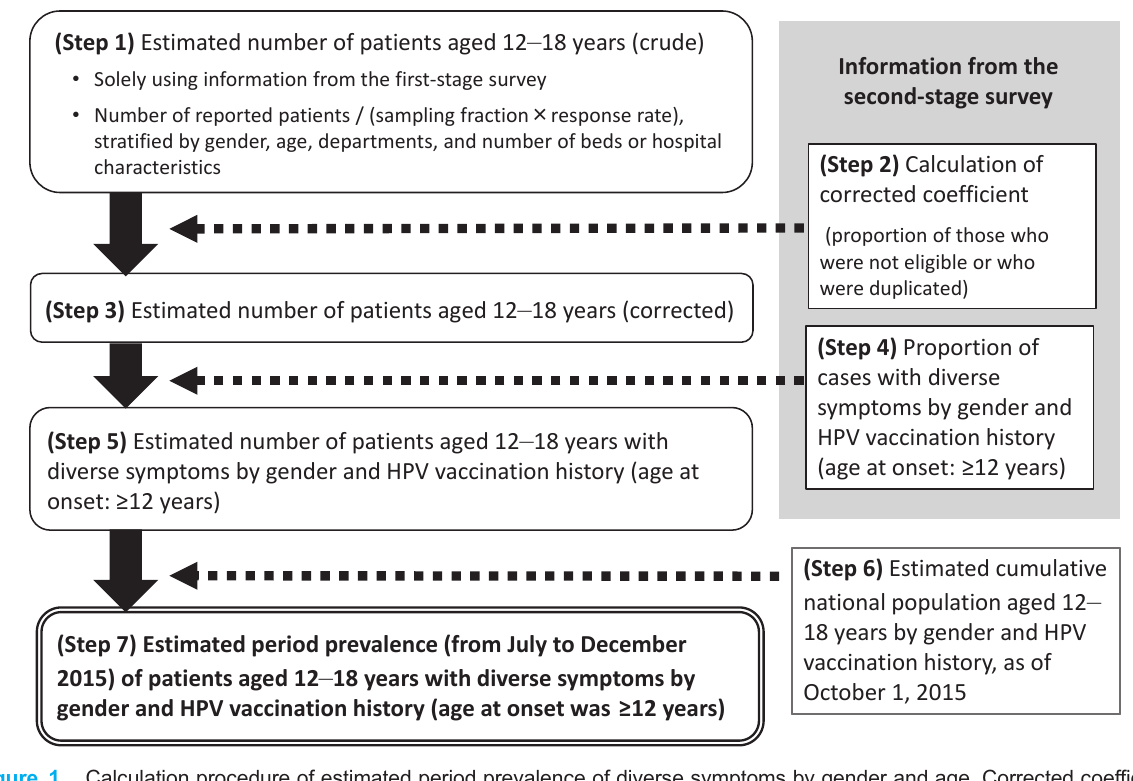
Figure 1. Calculation procedure of estimated period prevalence of diverse symptoms by gender and age. Corrected coe ffi cient was calculated by the number of non-eligible cases (eg, duration of symptoms was < 3 months, symptoms did not a ff ect their schooling / working) and duplicated cases (who were identical for gender, date of birth, name initials, prefectures of residence, and where other information was almost the same) as the numerator and the number of reported patients to the second-stage survey as the denominator. HPV, human papillomavirus.